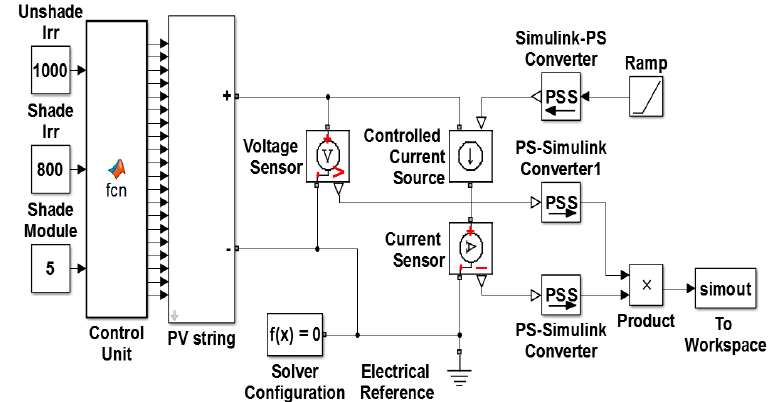
Figure 7. Photovoltaic string model.